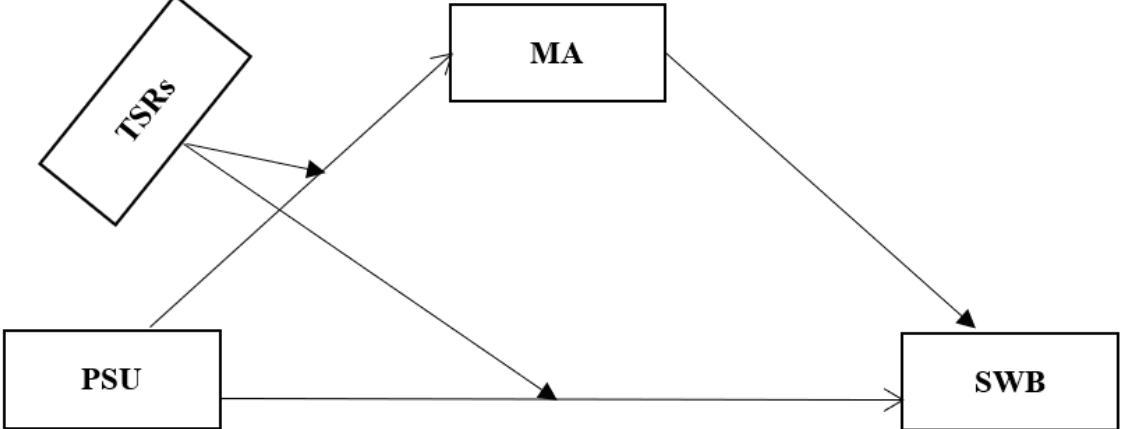
Figure 1. The moderated mediating effects model. Note: PSU = problematic smartphone use; MA = mathematics achievement; SWB = subjective well-being; TSRs = teacher–student relationships.